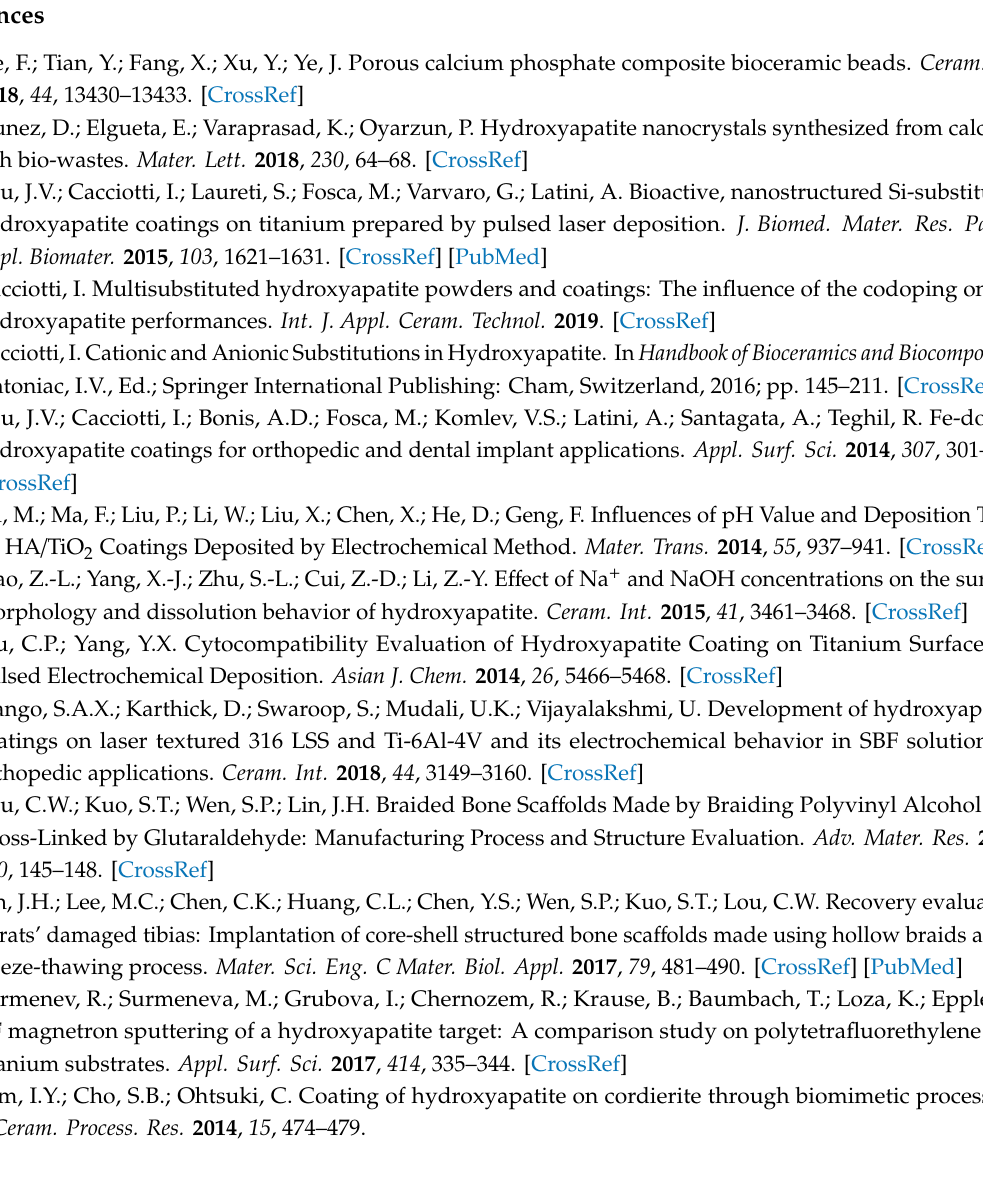
Table S1. The Ca / P ratio of HA coatings obtained by electrodeposition in the past two years by other authors; Figure S1. Surface morphology of undeposited braids, (A) SEM image of × 40 magnifications (B) SEM image of × 1000 magnifications; Figure S2. HA Crystal Diameter at 60 min